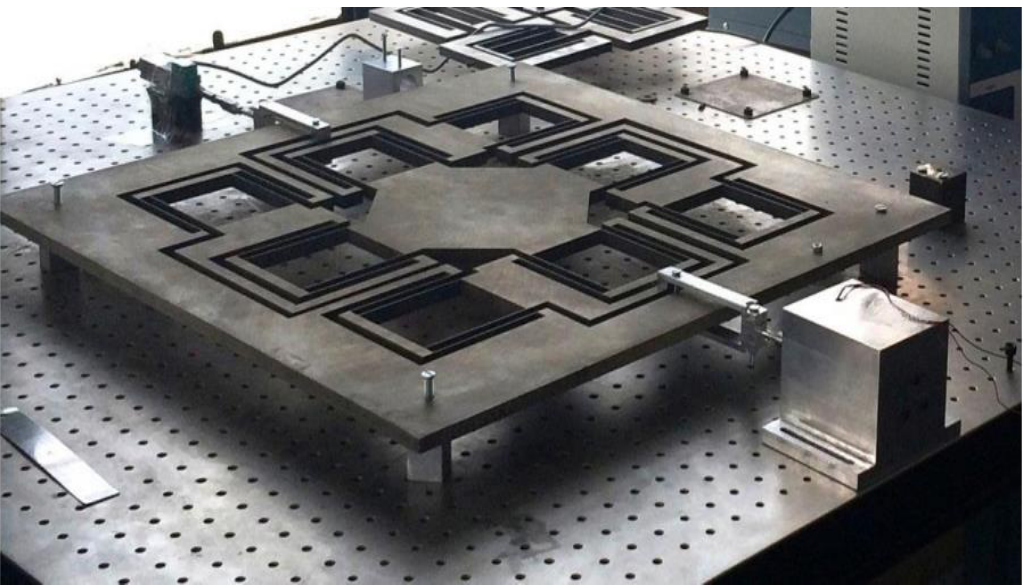
Figure 10. Manufactured XY flexural mechanism.